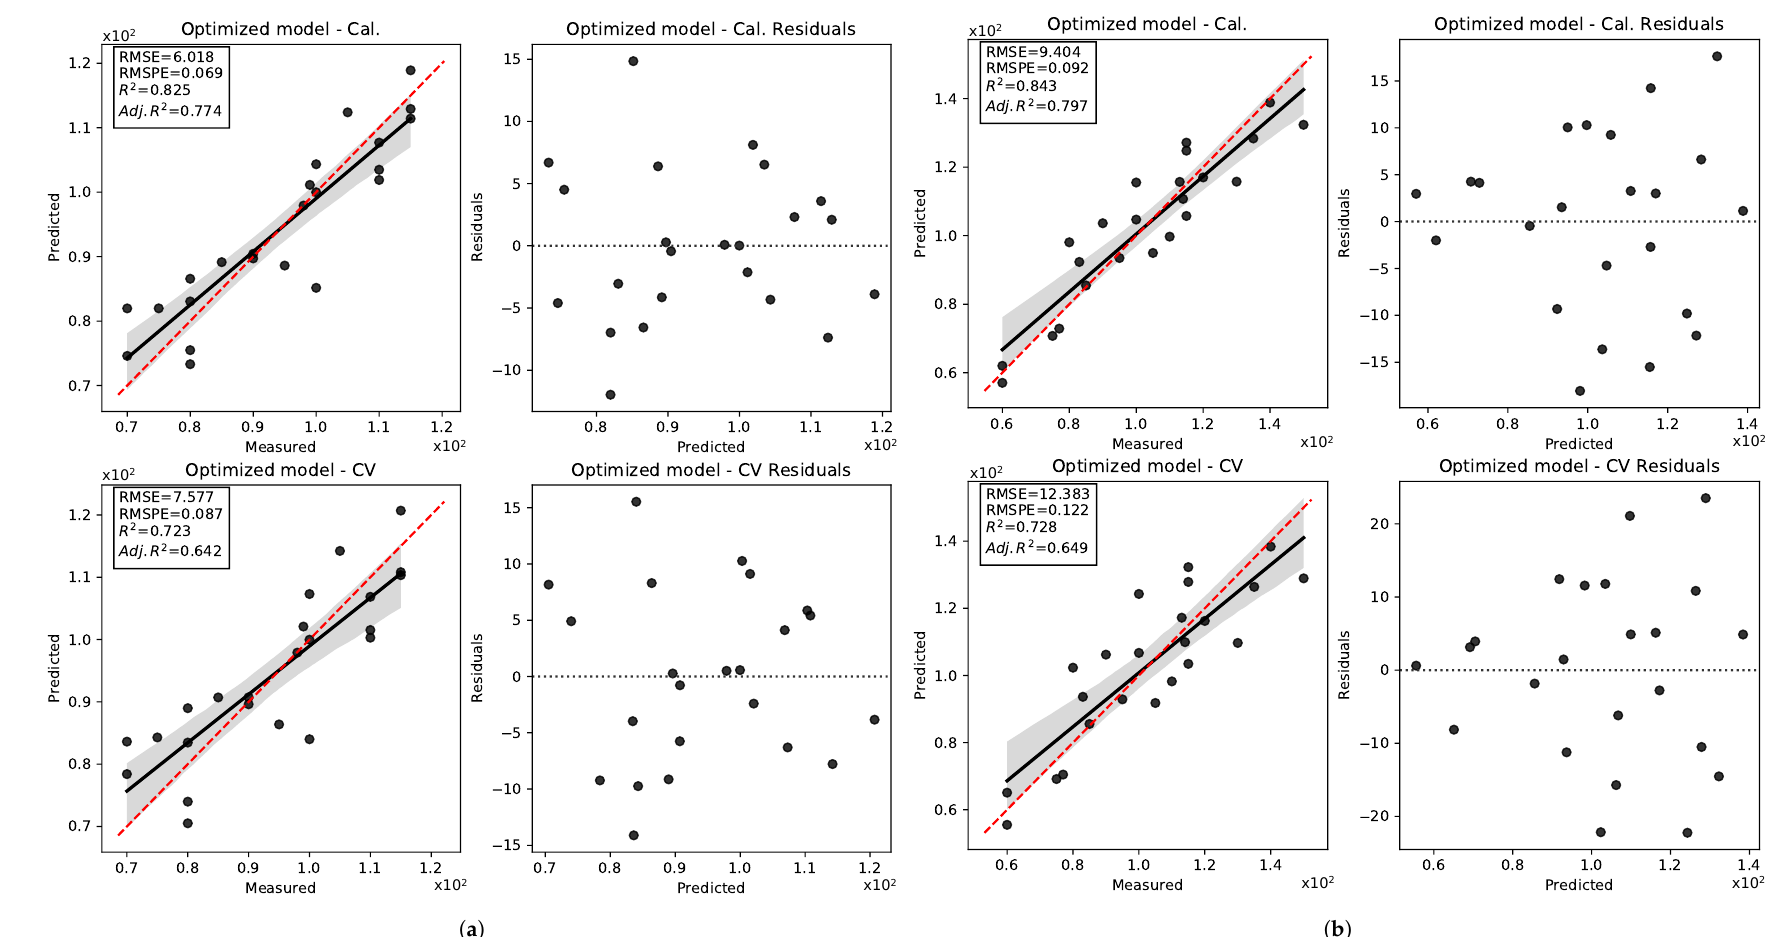
Figure 16. Regression results for snap bean 2019 seed length data set on ( a ) the GA-RENDVI model at 50 DAP for the early harvest stage and ( b ) the SA-RENVI model at 56 DAP for the late harvest